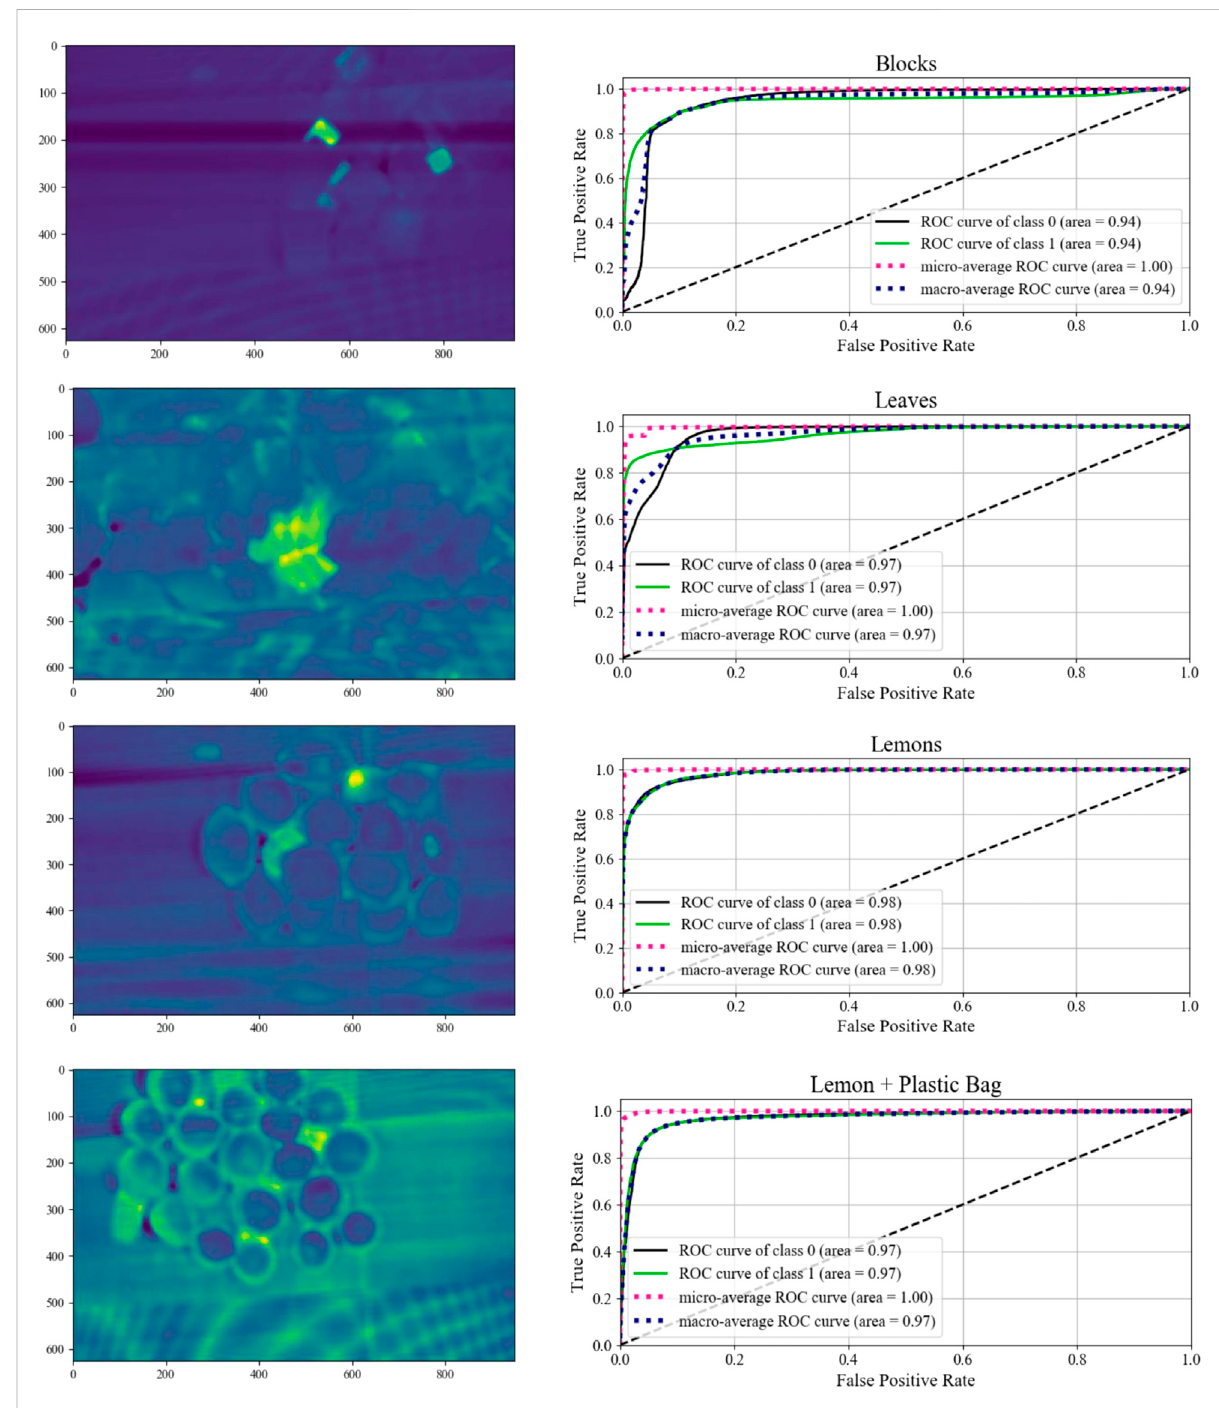
FIGURE 11 Mean absolute reconstruction error for each of the four environments and their associated Receiver Operator Curve (ROC) for multiple classi fi cation thresholds.